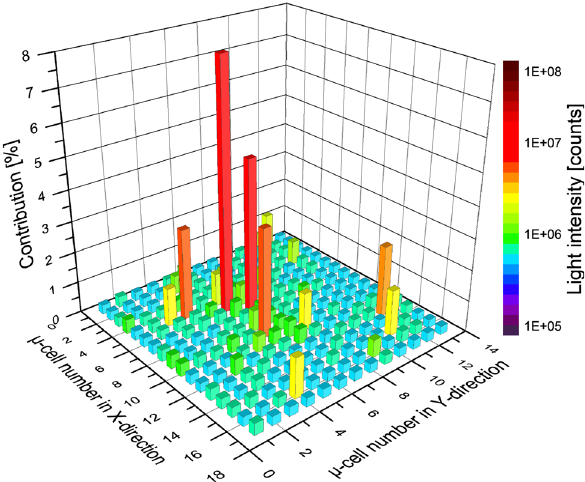
Fig. 2 Contribution of each micro-cell from Fig. 1 to the overall emit- ted light intensity